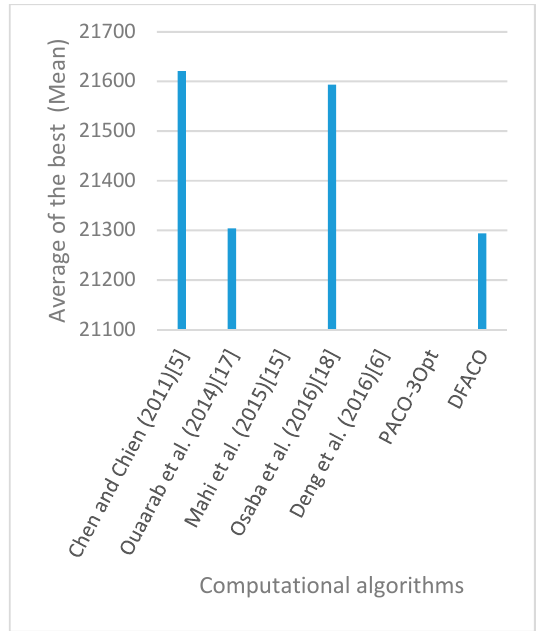
Figure 25. Average of best solutions obtained for instance kroD100 by all algorithms.